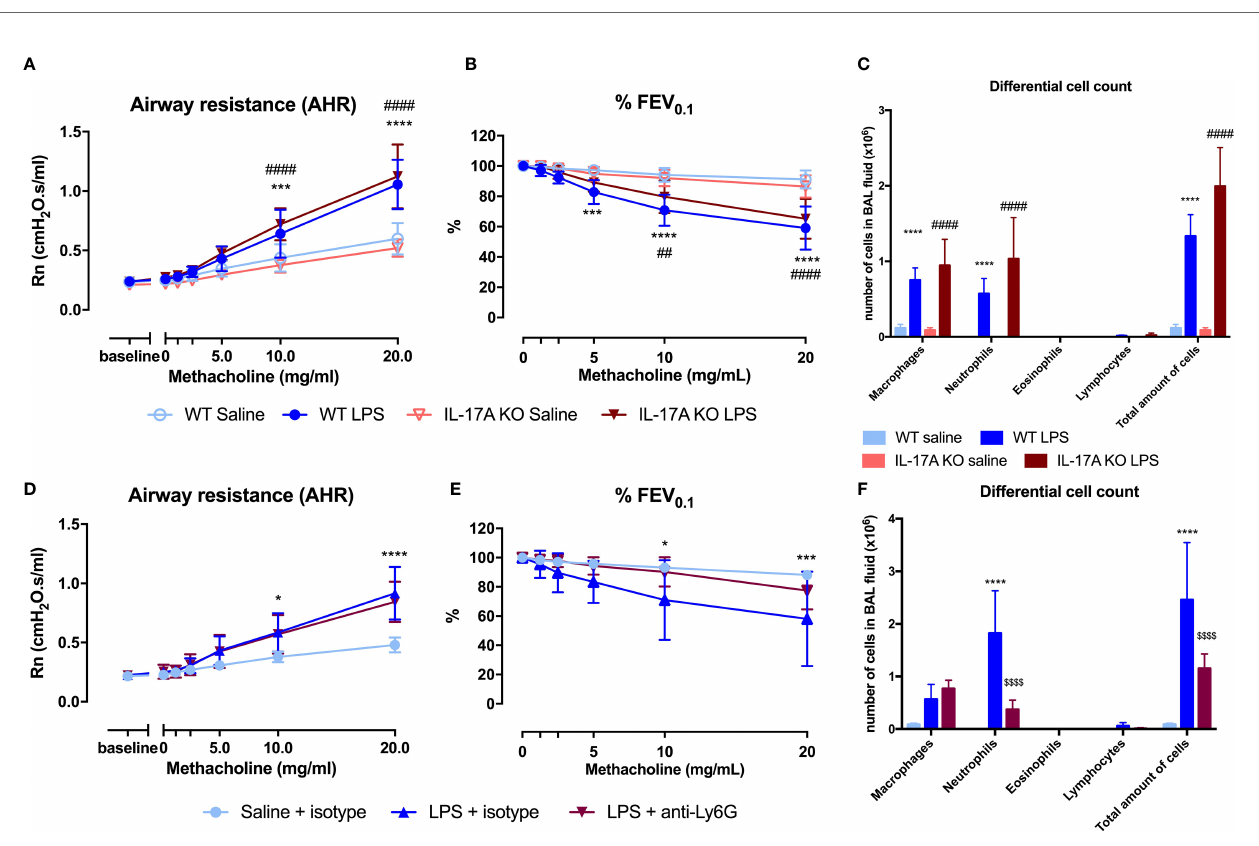
FIGURE 4 | Analysis of the role of IL-17A and neutrophils in induction of airway hyperreactivity in the LPS model. IL-17A -/- mice (on BALB/c background) were exposed to LPS (2 µg in 50 µl saline) via the nose for four consecutive days ( Supplementary Figure 1A ). Twenty-four hours after the last LPS challenge, lung function parameters were measured using the FlexiVent and BAL fl uid was obtained for differential cell count. Airway resistance [Rn, (A) ] and FEV 0.1 [%, (B) ] before and after methacholine provocation (0 – 20 mg/ml) were measured in saline-treated IL-17A -/- mice (n = 8) and LPS-treated IL-17A -/- mice (n = 8). (C) Differential cell count in BAL fl uid of the same mice. (D – F) Neutrophils were depleted by anti-Ly6G mAb (250 m g injected intraperitoneally on days -1, 1, and 3 as shown in Supplementary Figure 1B ). Twenty-four hours after the last LPS challenge, lung function parameters were measured using the FlexiVent and BAL fl uid obtained for differential cell count. Airway resistance [Rn, (D) ] and FEV 0.1 [%, (E) ] before and after methacholine provocation (0 – 20 mg/ml) were measured in saline-treated isotype injected wild type mice (n = 5), LPS-treated isotype injected wild-type mice (n = 5) and LPS-treated and anti-Ly6G-injected wild-type mice (n = 8). (F) Differential cell count in BAL fl uid of the same mice. *p <0.05; ***p < 0.001; ****p < 0.0001 (WT saline versus WT LPS and saline + isotype versus LPS + isotype). ## p < 0.01; #### p < 0.0001 (IL17A -/- saline versus IL-17A -/- LPS). $$$$ p < 0.0001 (LPS + isotype versus LPS +